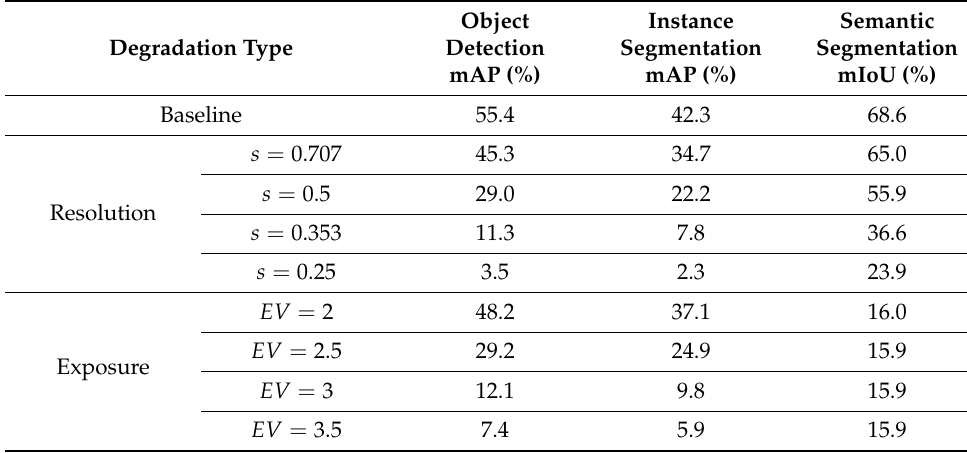
Table 4. Result of inference by convolutional neural network (CNN) models trained on baseline images and applied to testing images with various levels of image